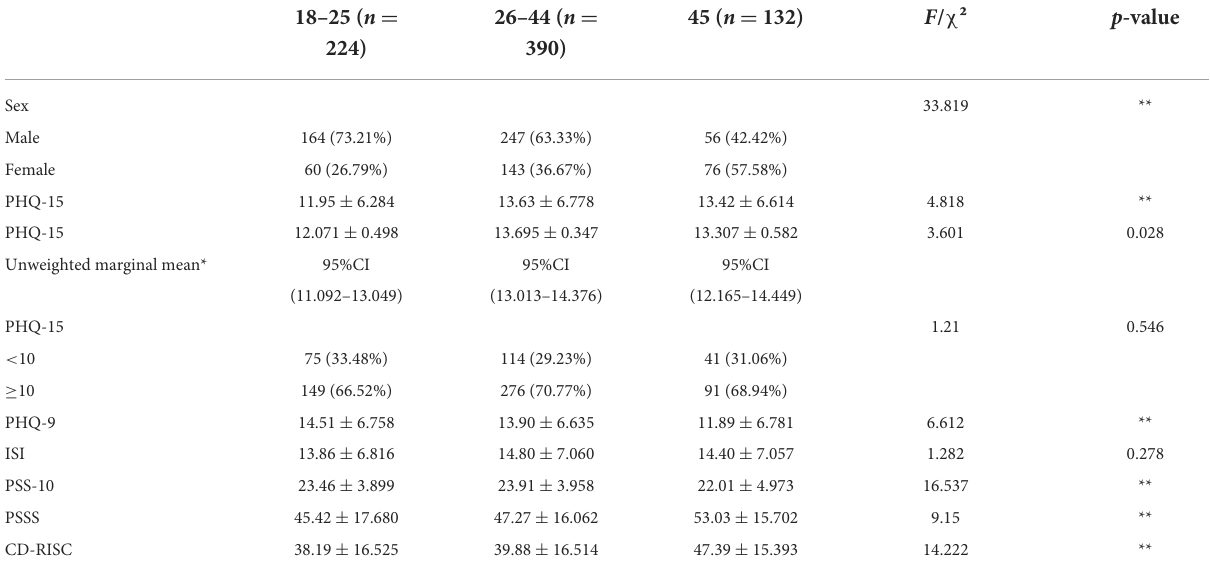
TABLE 1 Comparison of different age groups.